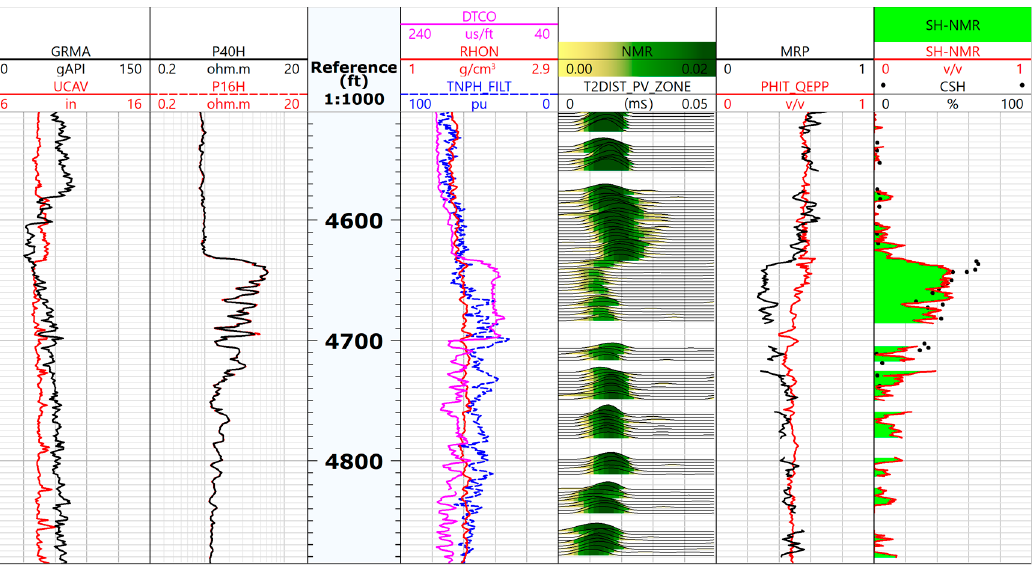
Figure 4. Comparison of the processing results of NMR logging saturation models with core data.